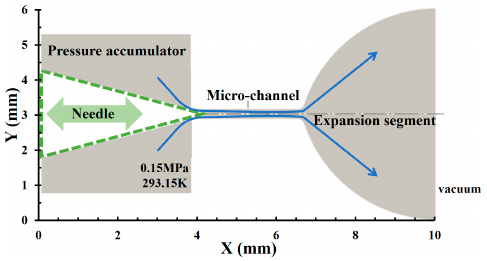
Figure 1. The micro ‐ nozzle structure with a large length ‐ to ‐ diameter ratio of 4.5 used in this study. Figure 1. The micro-nozzle structure with a large length-to-diameter ratio of 4.5 used in this